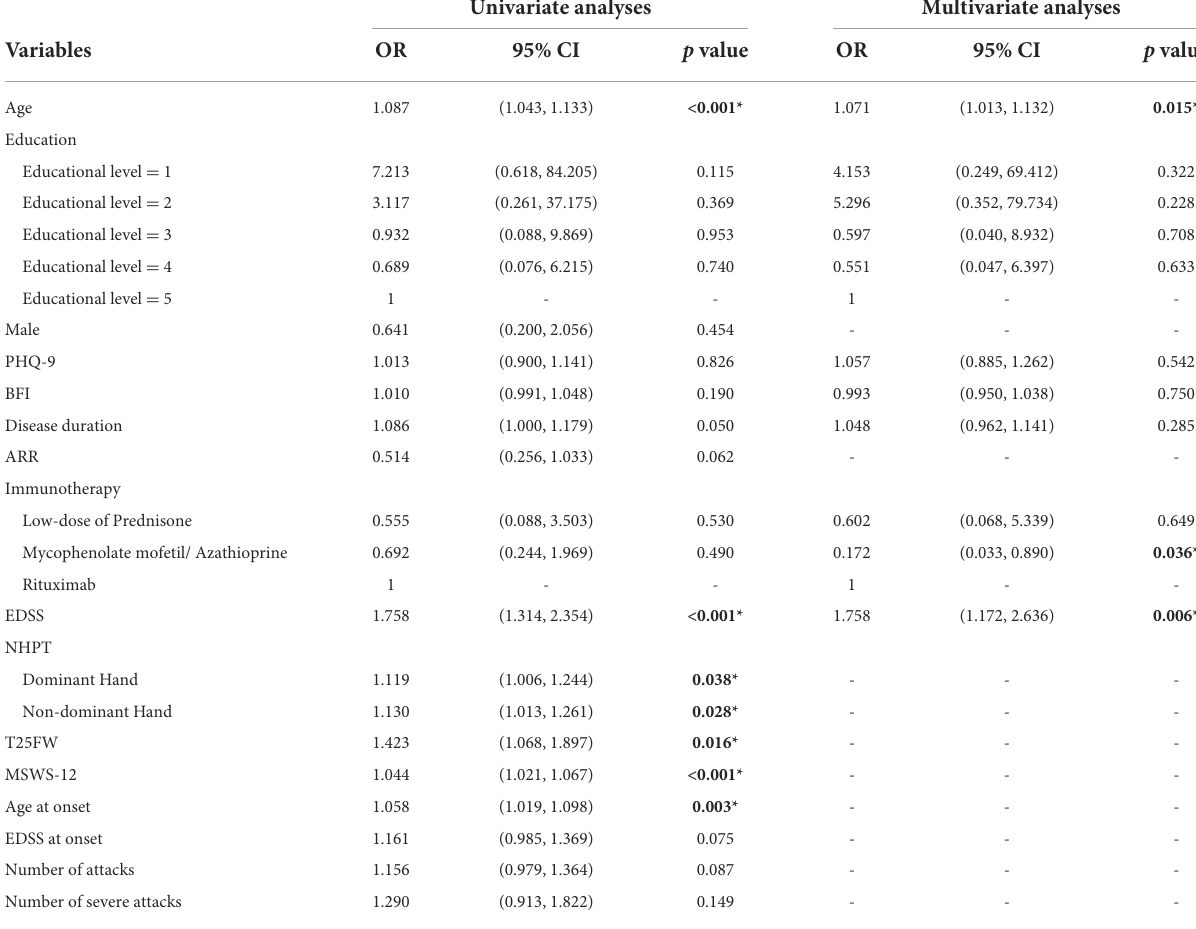
(Educationwascategorizedintofivelevels:“1” = primaryschooling,“2” = secondaryschooling,“3” = highschool,“4” = collegeeducation,and“5” = graduateeducation). *Representsp < 0.05. Thebold p